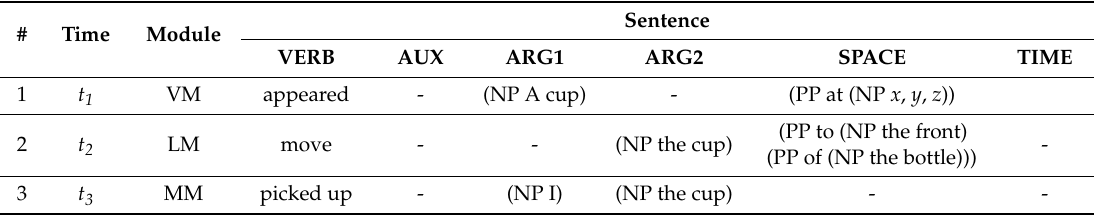
Table 2. Examples of sentences stored in sentential